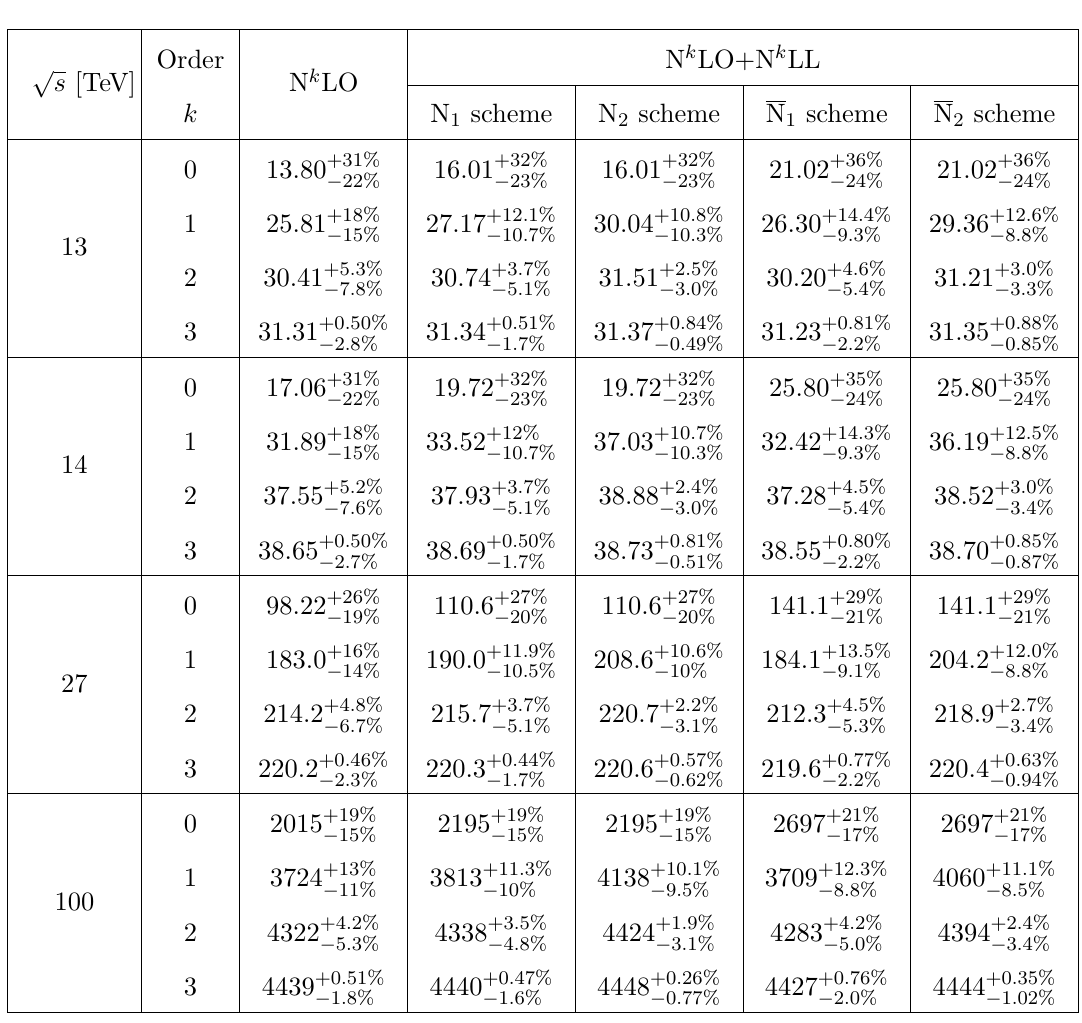
Table 1 . Inclusive cross sections (in unit of fb) with the m t → ∞ approximation at both fixed order N k LO and resummation N k LO+N k LL ( k = 0 , 1 , 2 , 3 ) in the center-of-mass energies 13 , 14 , 27 , 100 TeV. In the resummation, the results of four different resummation schemes have been shown. The quoted uncertainties are from the 7 -point scale variations with the central scale µ 0 = m hh 2